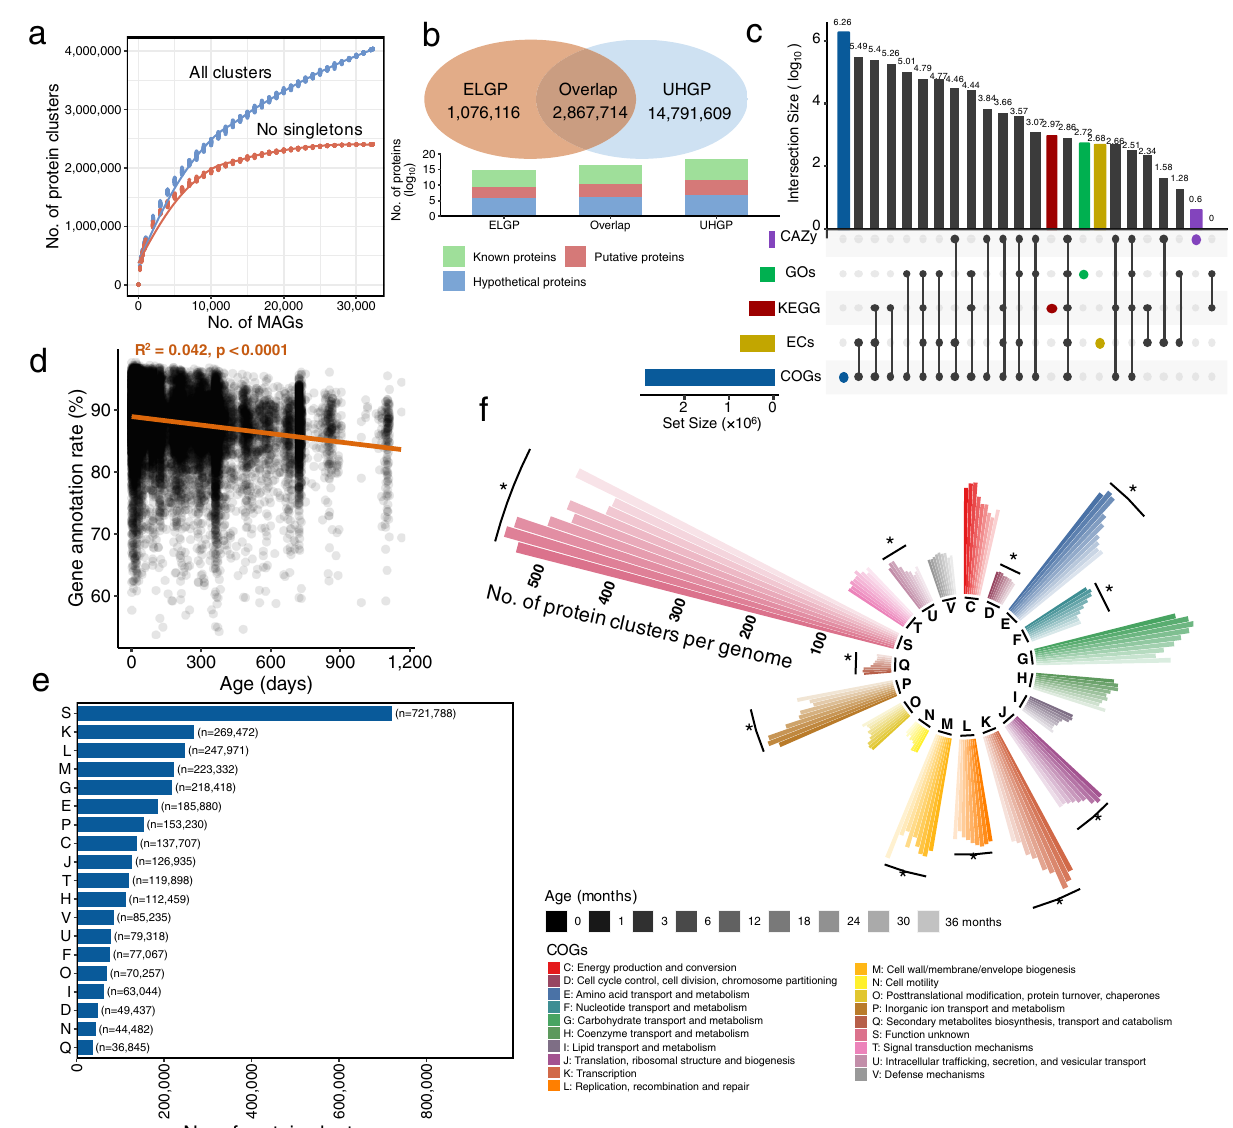
Fig. 2| TheELGPcatalogandfunctionalcharacterization. a Rarefactionanalysis of the number of protein clusters of early-life gut microbiome at 95% amino acid identity asa function of the number ofgenomes included. Curves are depictedfor all the protein clusters and after excluding singleton protein clusters (containing only one protein sequence). b Overlap between the ELGP (orange) and UHGP (blue), both clustered at 95% amino acid identity. The bars at bottom indicate the number of proteins that the cluster representatives from three categories (ELGP exclusive, Overlap, and UHGP exclusive) encode,strati fi ed as known, putative, and hypothetical proteins. c Number of proteins with functional annotation across the fi ve functional categories and their degree of overlap. Vertical bars represent the number of proteins unique (color) to each functional category or shared (black)